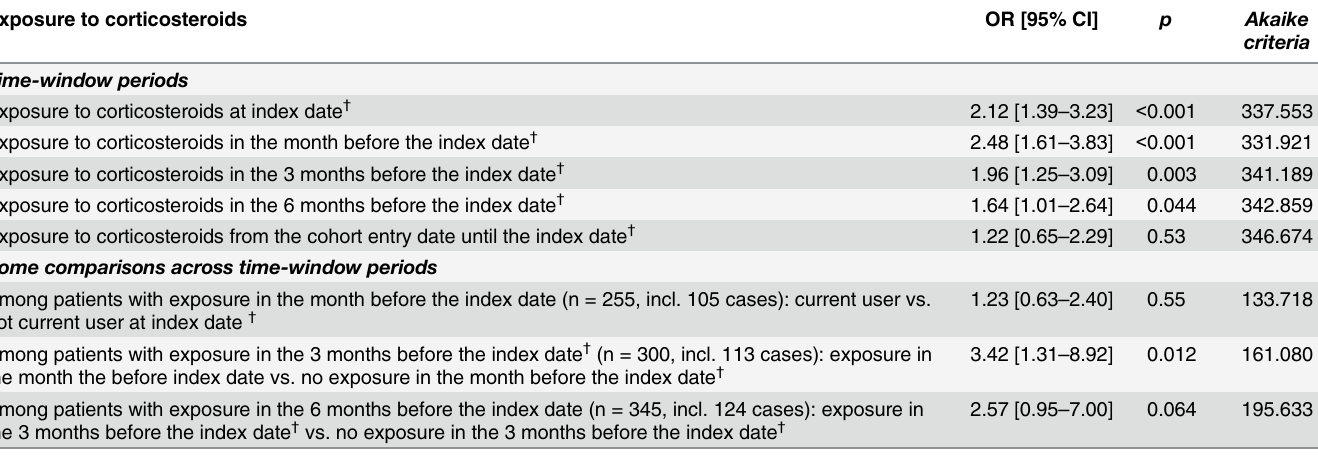
Table 3. Multivariate models * assessing the link between exposure to corticosteroids during the various time-windows and occurrence of severe infection. Each line shows the adjusted result of exposure to corticosteroids with a given time-window period. Exposure to